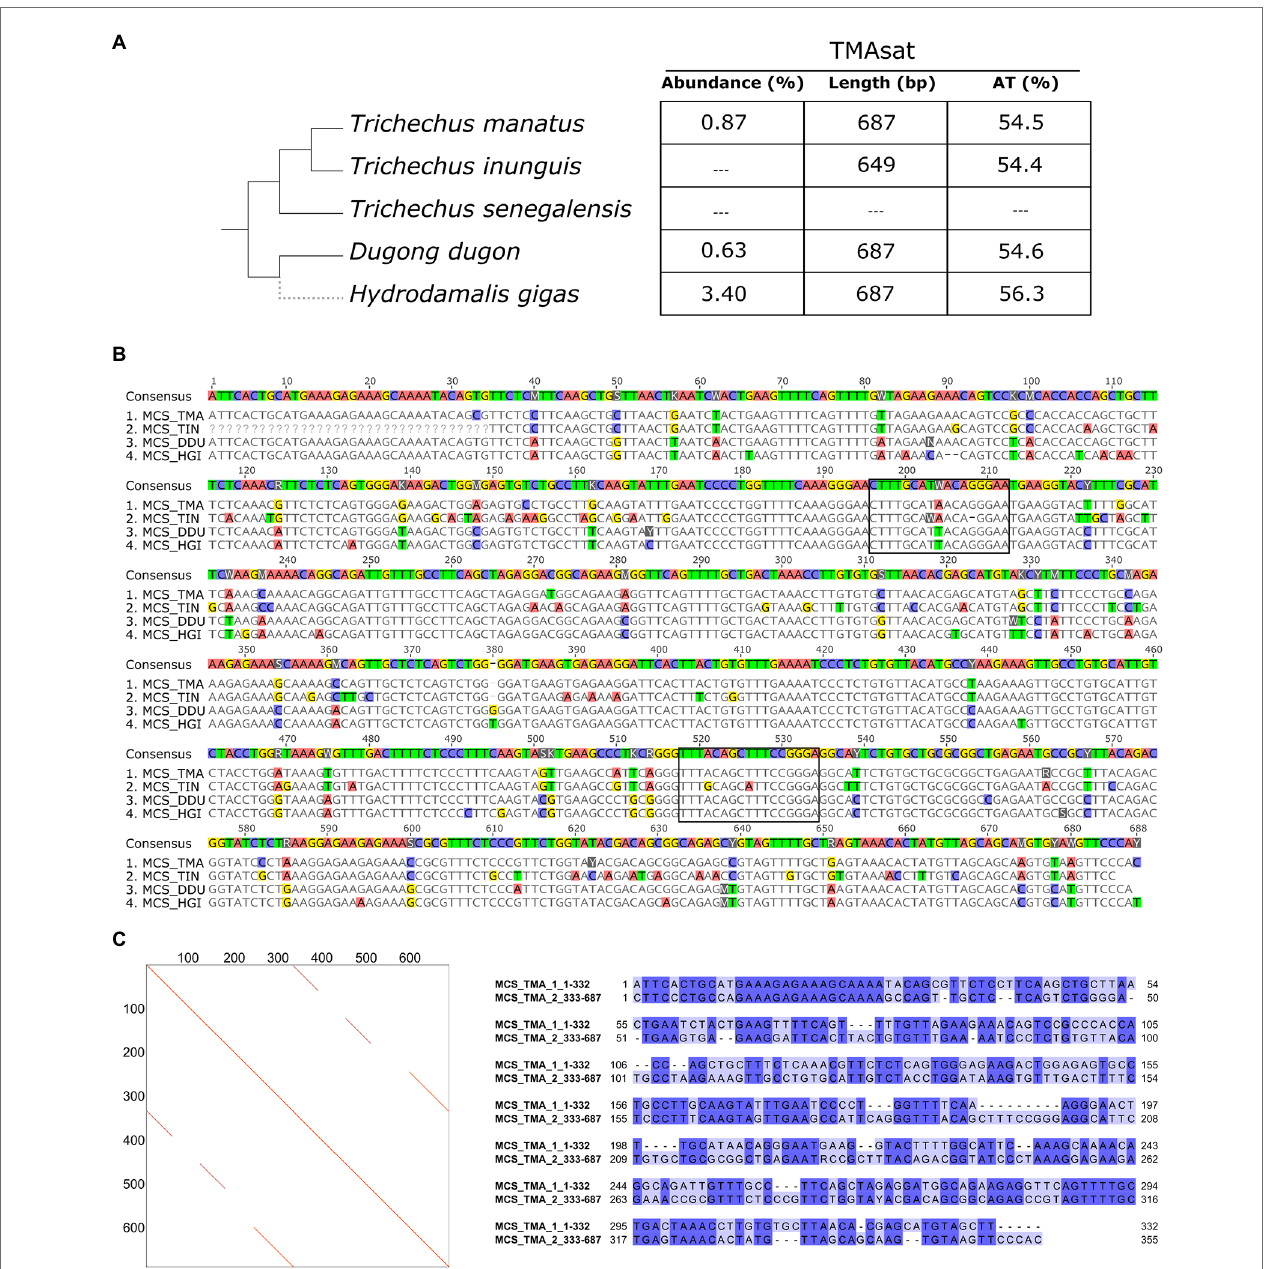
FIGURE 1 | (A) TMAsat abundance, monomer length and AT content of the monomers for the analyzed species. (B) Alignment of TMAsat MCS from Trichechus manatus , Trichechus inunguis , Dugong dugon , and Hydrodamalis gigas showing the two putative CENP-B box like motifs. (C) Dot plot comparison of the TMAsat MCS sequence from T. manatus against itself and pairwise alignment of TMAsat position 1–332 against 333–687, with 55.8% of DNA sequence